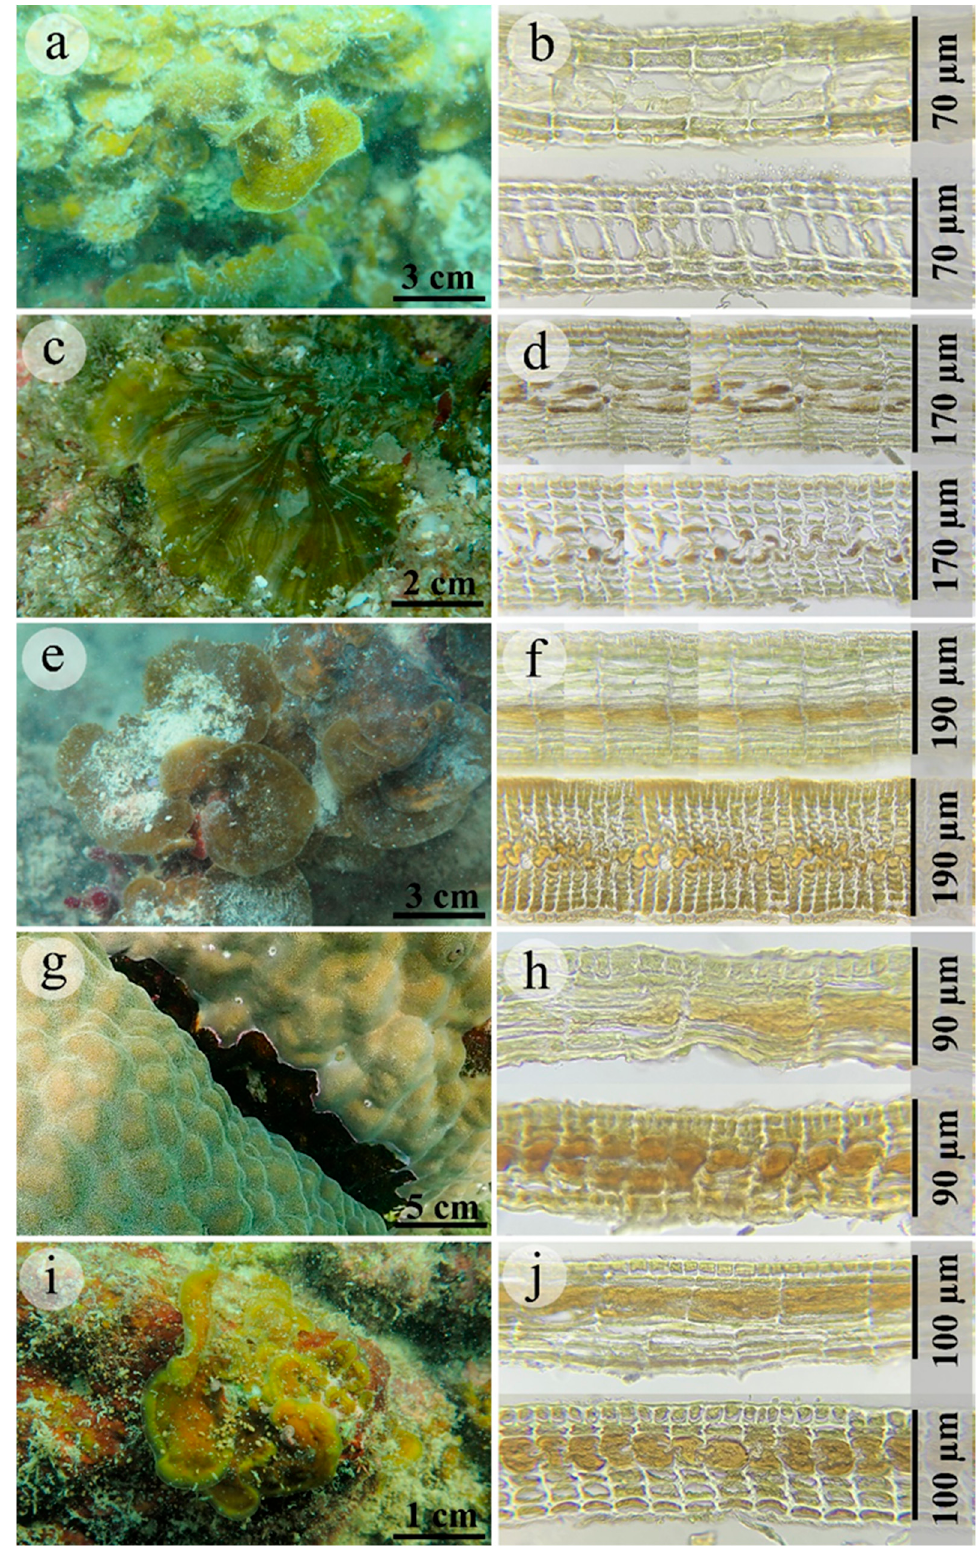
Figure 2. In situ photographs and corresponding transverse and cross-section through middle of thallus: Lobophora lamourouxii , THNHM-P-2020-0291 ( a , b ), Lobophora obscura 13, THNHM-P-2020-0262 ( c , d ), L.obophora obcura 12, THNHM-P-2020-0277 ( e , f ), Lobophora chumphonensis sp. nov., THNHM-P-2020-0258 ( g , h ), Lobophora thailandensis sp.nov., THNHM-P-2020-0287 ( i , j ).